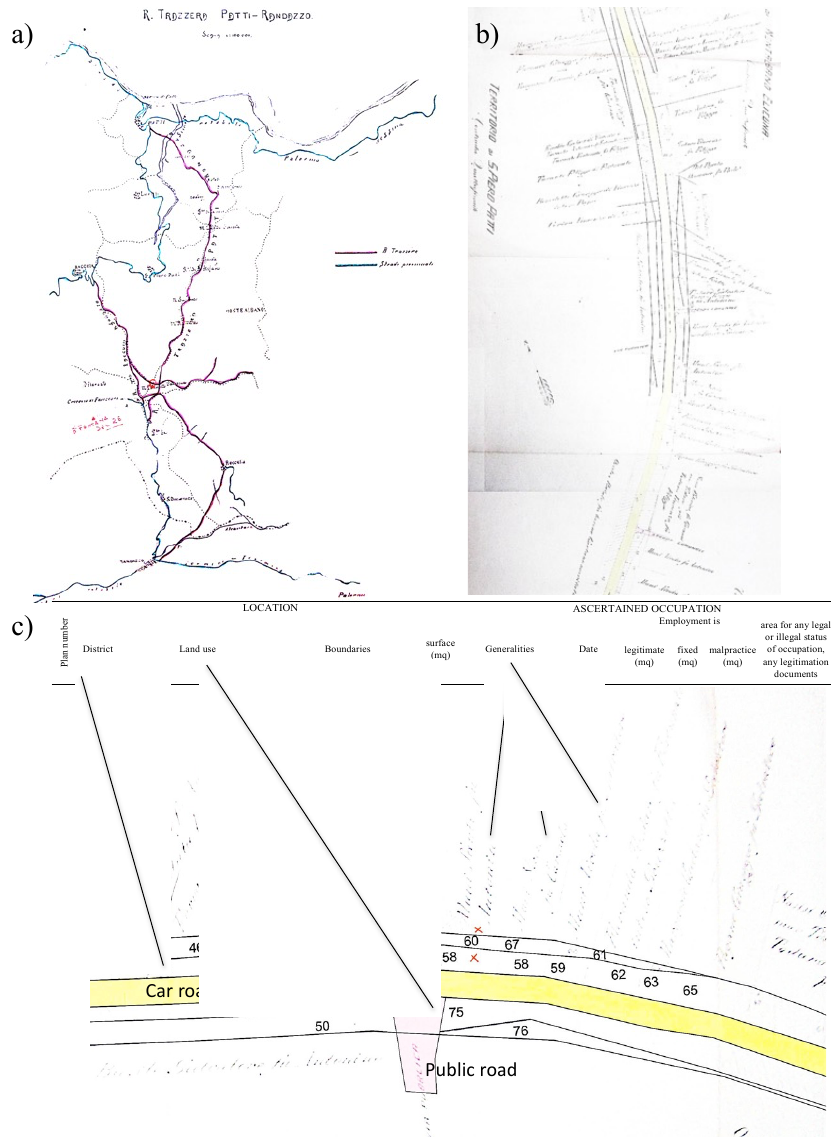
Figure 2. Sample of cartography of a masterplan: ( a ) location; ( b ) stretch of the trazzera ; ( c ) parts converted into a road, borders of the neighboring properties and quarters crossed (source: Service 5—Management of State Forest, Trazzerale and Civic Uses).